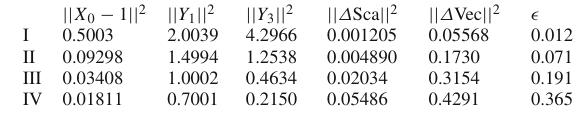
for m b . m . = 6 . 852 MeV, Z 2 = 1 . 0016, where Δ Sca and || are given in GeV, while Δ Vec, || X || Y 1